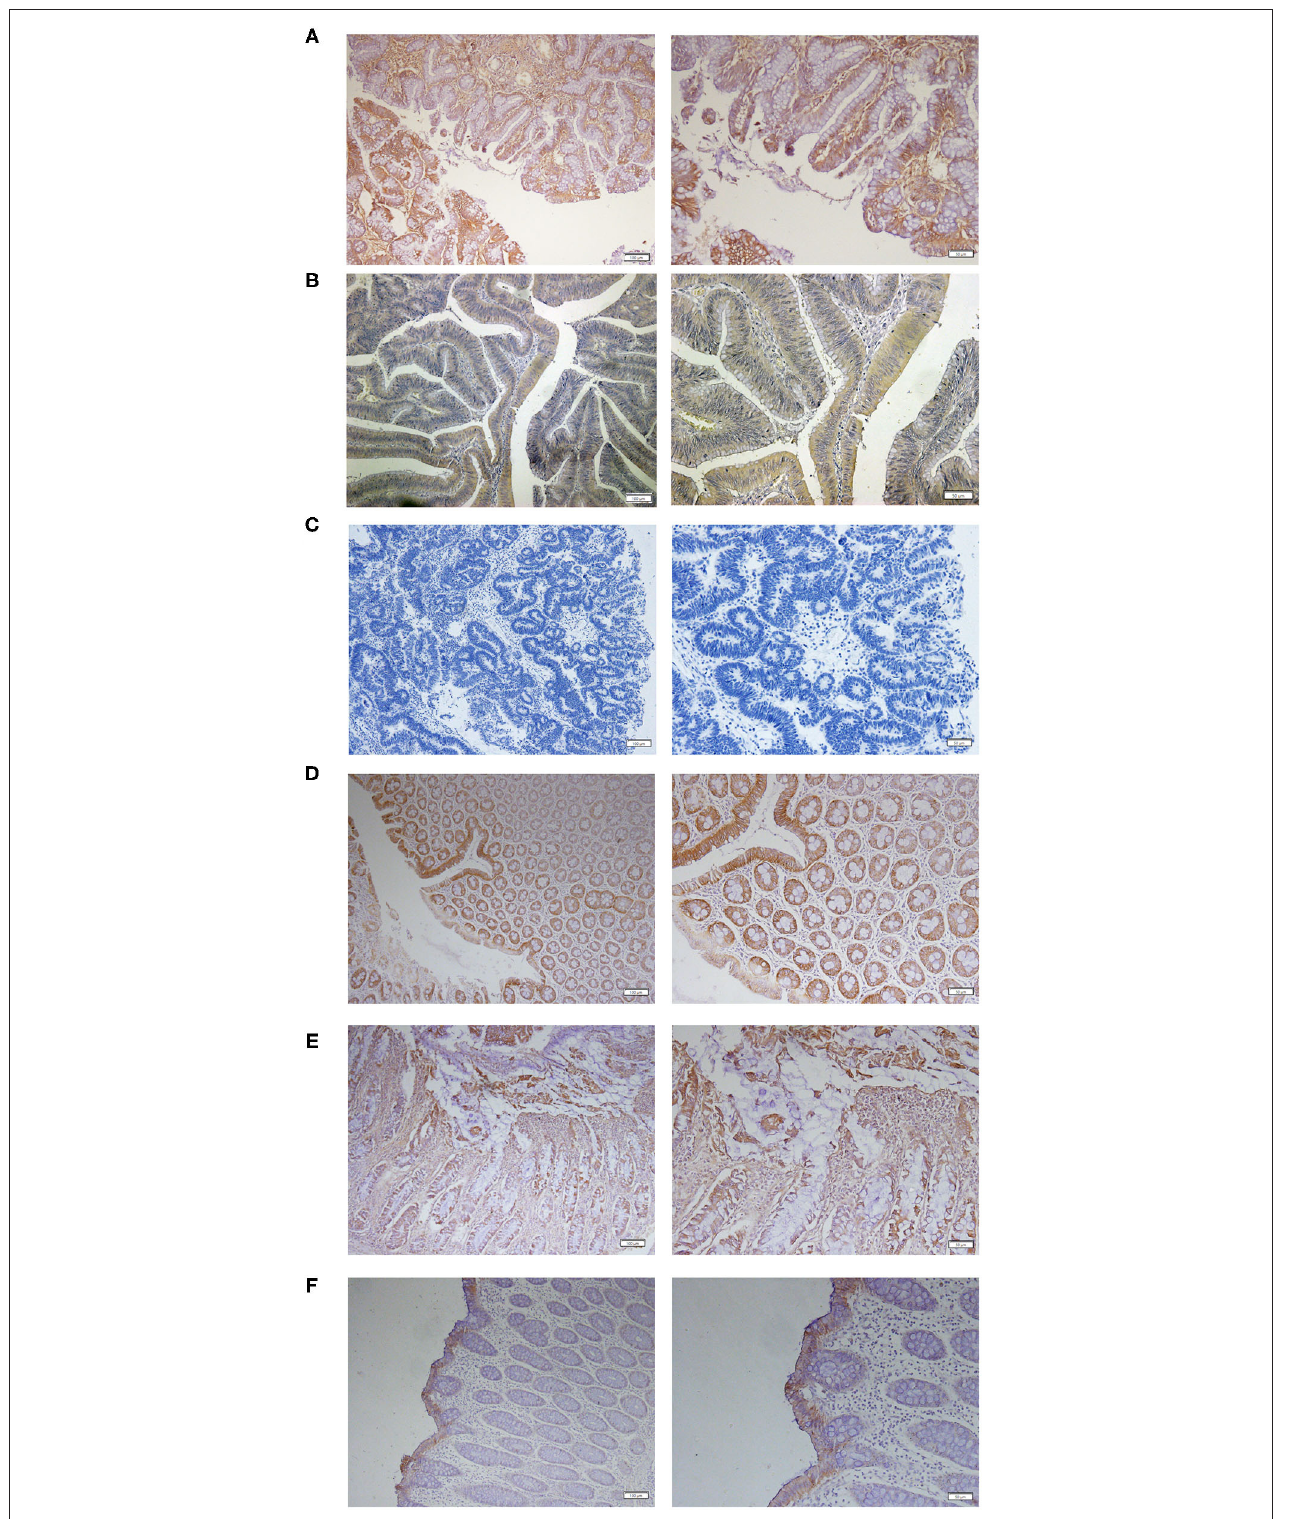
FIGURE 1 | Expression of TMEM16A in human colorectal cancer. (A) Representative IHC images of medium expression of TMEM16A. (B) Representative IHC images of low expression of TMEM16A. (C) Representative images of negative staining for TMEM16A. (D) Representative images of IHC staining showing TMEM16A expression in glands and mucosa of colorectal cancer tissues. (E) Expression of TMEM16A in glands and connective tissue of colorectal cancer. (F) Expression of TMEM16A on the mucosal surface of colorectal carcinoma.